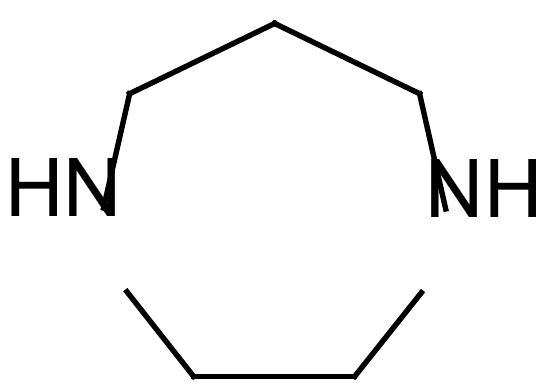
Figure 1: Structure of1,4-diazacycloheptane